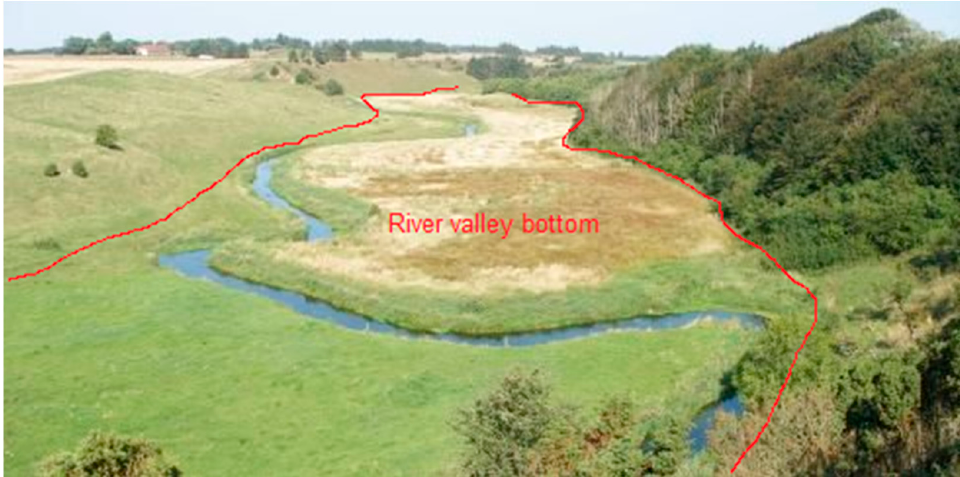
Figure 1. Conceptualization of the river valley bottom at a section of the Villestrup stream, Denmark, showing the valley bottom as a flat to low slope area adjacent to a river and bounded by increasing slopes (Photo by the Danish Nature Agency).